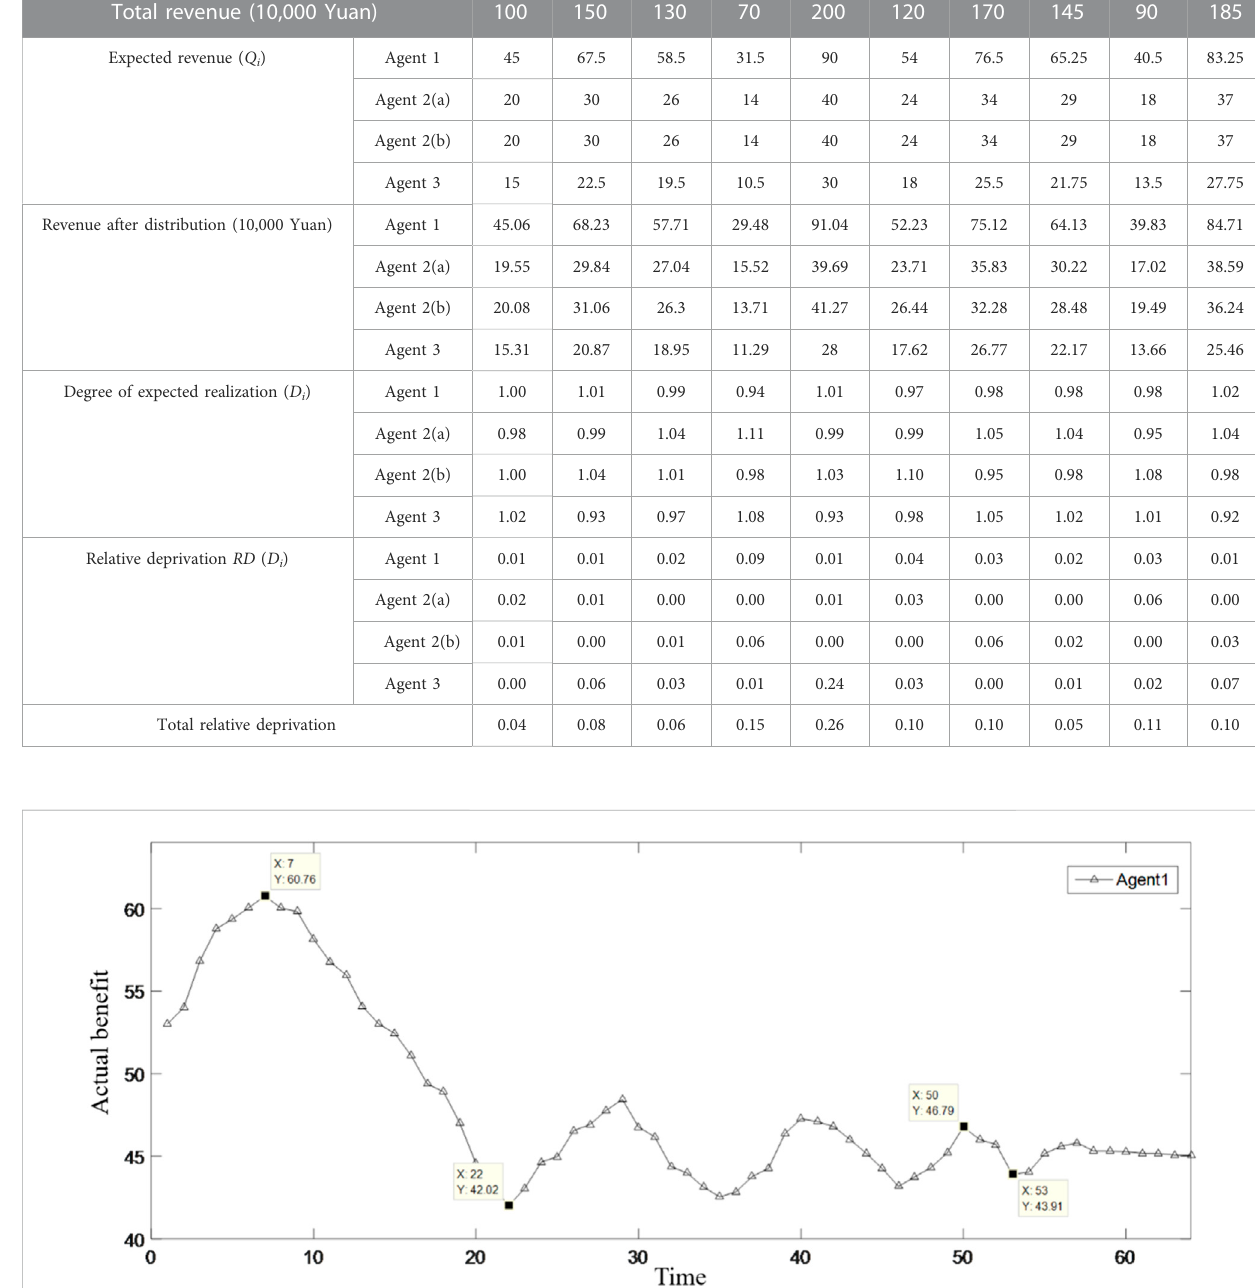
TABLE 2 10 groups of bene fi t distribution based on the extended ant colony labor division. Number of bene fi t distribution